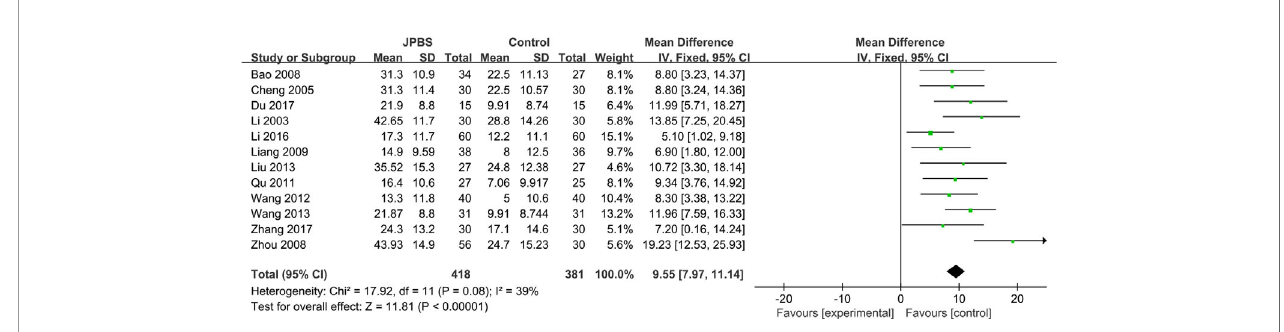
FIGURE 5 | Forest plot of Hb levels.